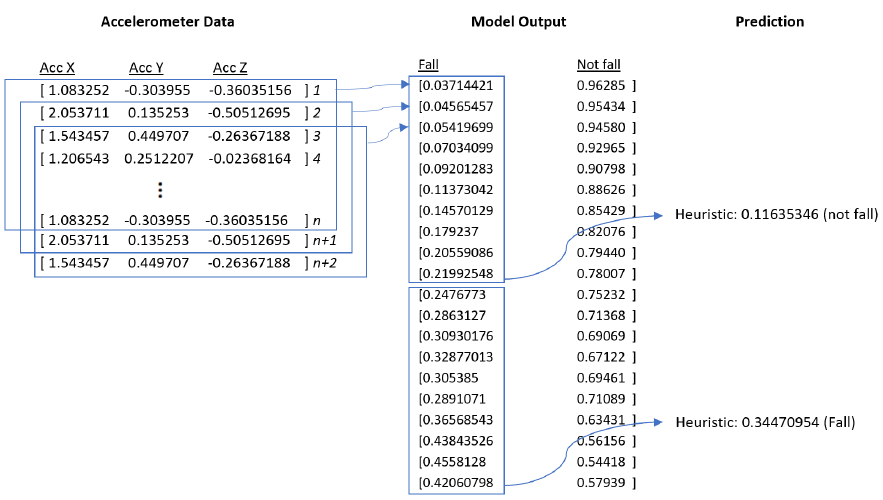
Figure 5. Prediction scheme for deep